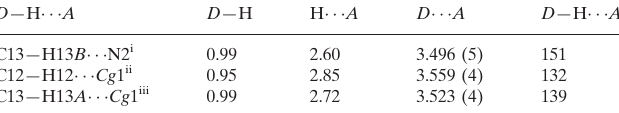
Hydrogen-bond geometry (A˚ , (cid:3)